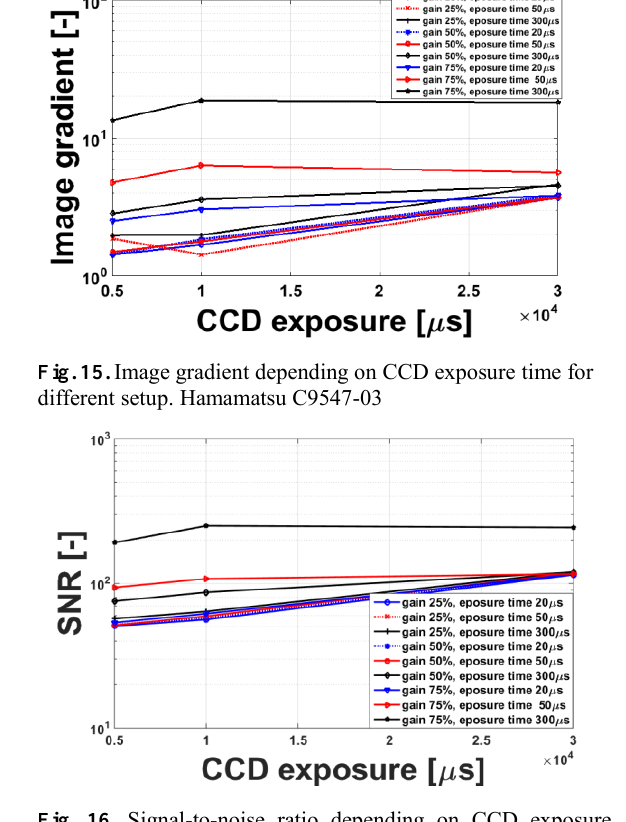
Fig. 16. Signal-to-noise ratio depending on CCD exposure time for different setup. Hamamatsu C9547-03 C10880-03 noise ratio after 10000 µs exposure time of CCD camera.